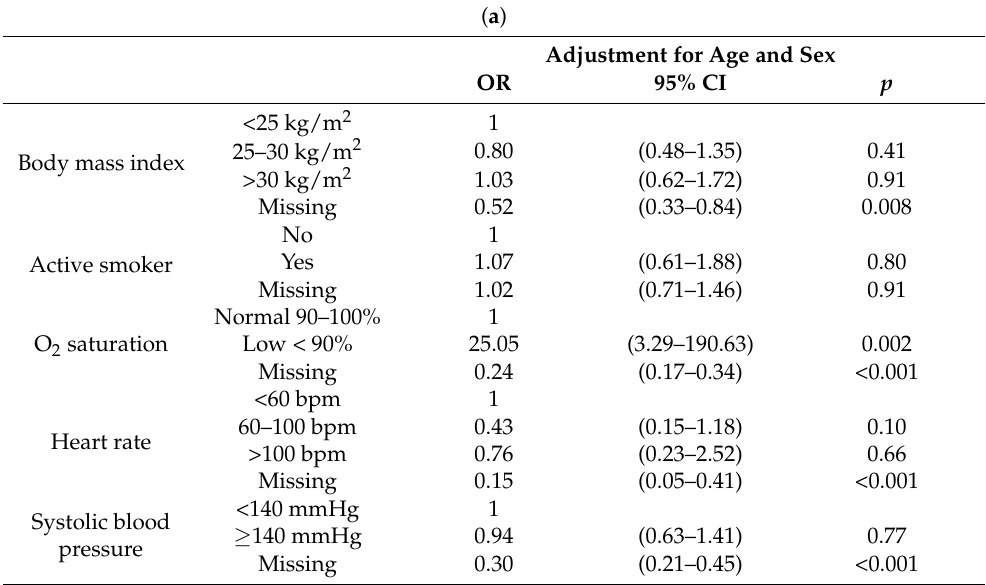
Table 2. (a) Variables associated with hospital admission for COVID-19, multivariable analysis. Adjustment for age and sex. (b) Variables associated with hospital admission for COVID-19, multi- variable analysis. Multivariable